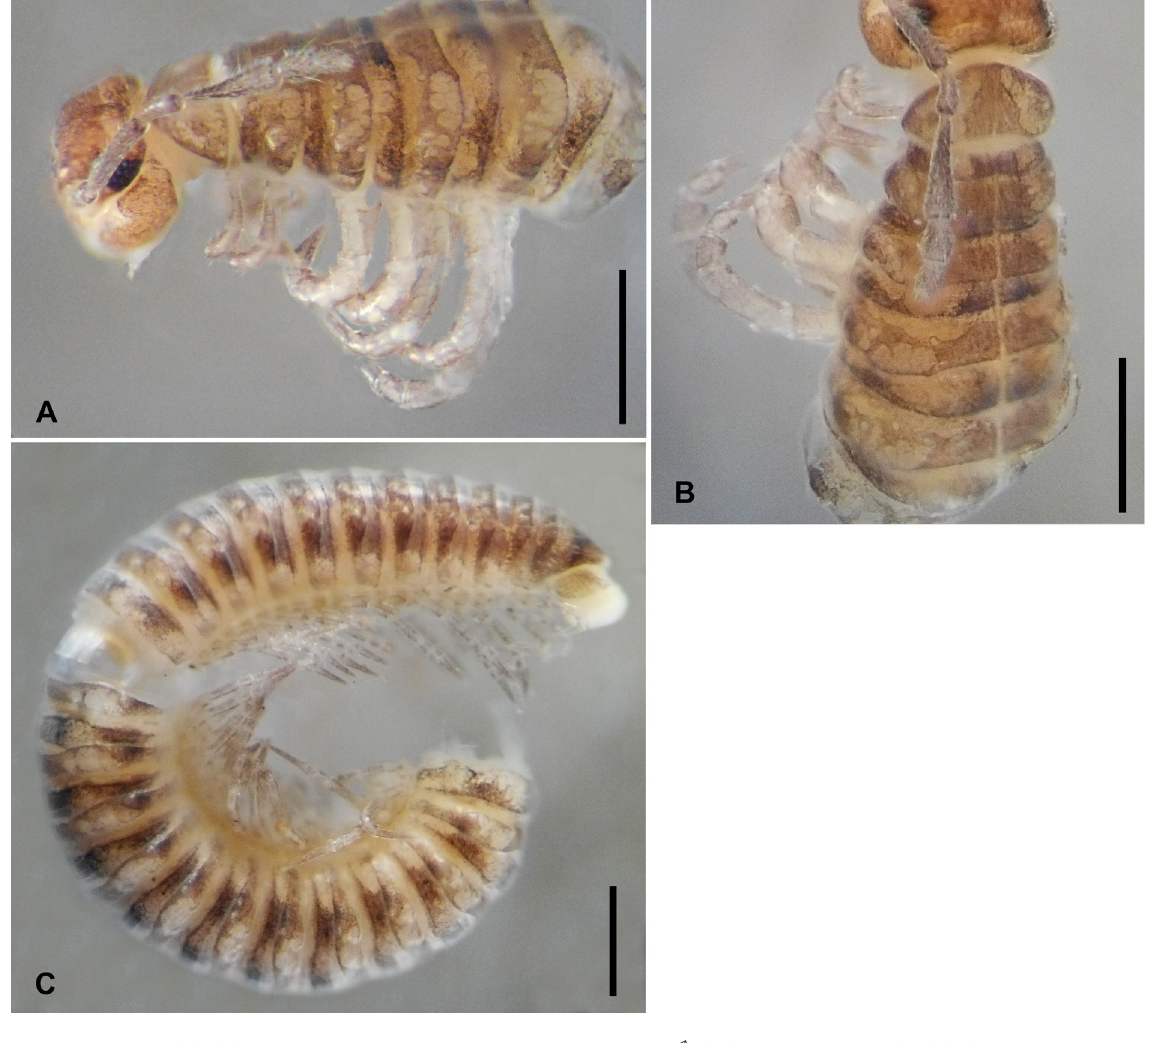
Fig. 4. External habitus of Anamastigona strasseri sp. nov., ♂, holotype. A . Head with first 7 segments, lateral, slightly dorsal view. B . Head with first 7 segments, dorsal, slightly lateral view. C . Segment 8 to telson, lateral view. Scale bars = 0.5